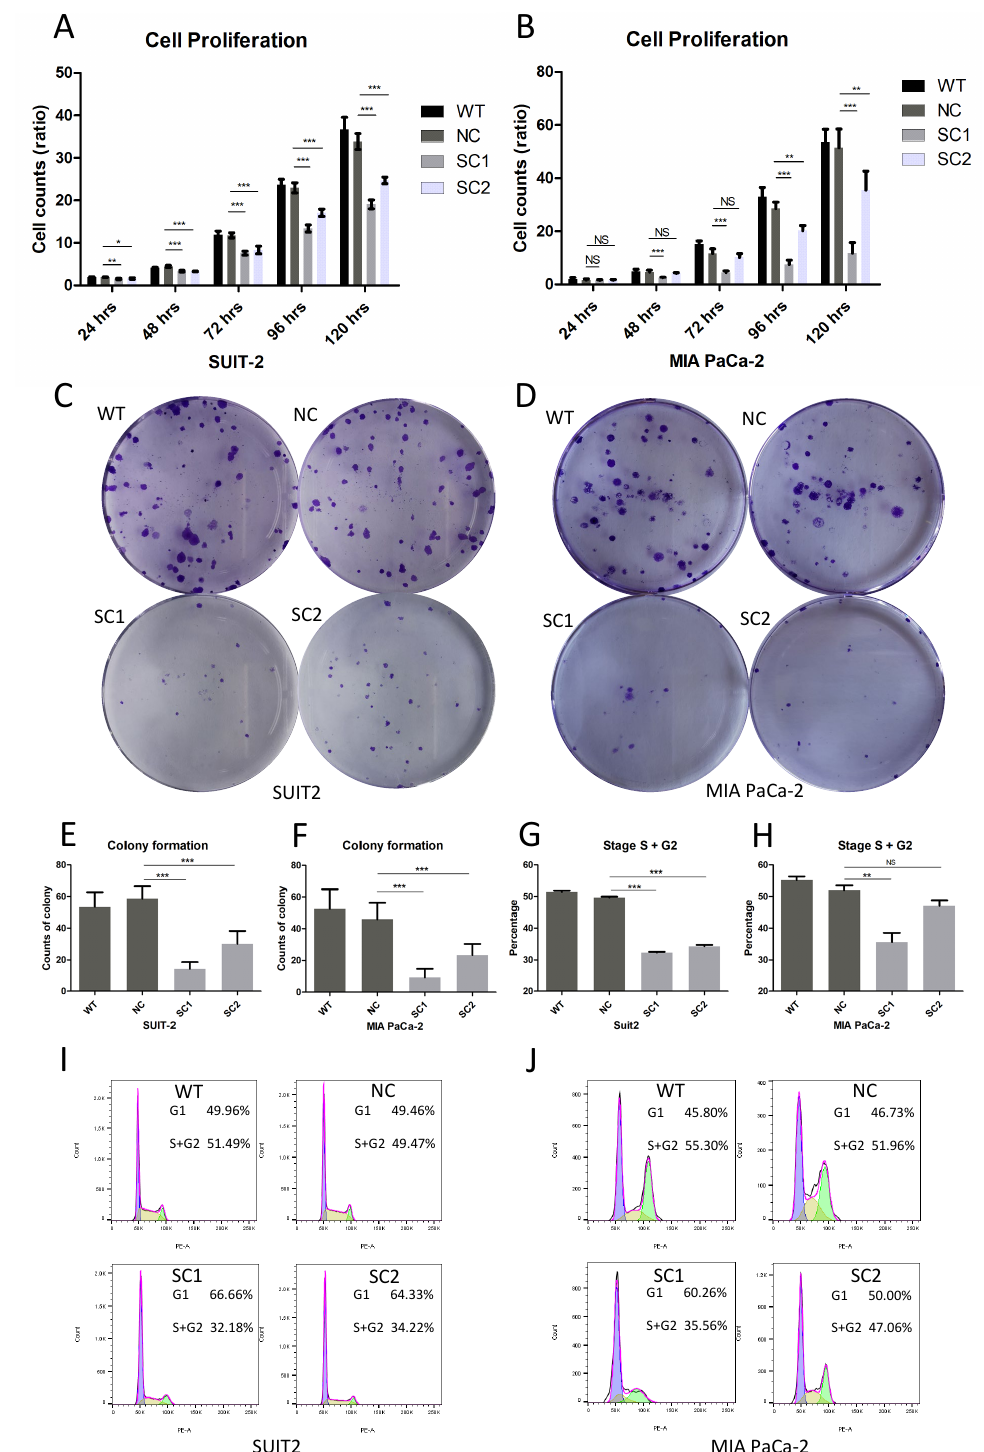
Figure 3. Knockout of PCSK6 suppressed cell proliferation. ( A ) Cell proliferation ratios of SUIT-SCs and controls at 24 h, 48 h, 72 h, 96 h and 120 h were analyzed, respectively (WT vs. NC p = 0.997, NC vs. SC1 p = 0.004 and NC vs. SC2 p = 0.023 at 24 h. WT vs. NC p = 0.118, NC vs. SC1 p < 0.001 and NC vs. SC2 p < 0.001 at 48 h. WT vs. NC p = 0.994, NC vs. SC1 p < 0.001 and NC vs. SC2 p < 0.001 at 72 h. WT vs. NC p = 0.775, NC vs. SC1 p < 0.001 and NC vs. SC2 p < 0.001 at 96 h. WT vs. NC p = 0.171, NC vs. SC1 p < 0.001 and NC vs. SC2 p < 0.001 at 120 h). ( B ) Cell proliferation ratios of MIA-SCs